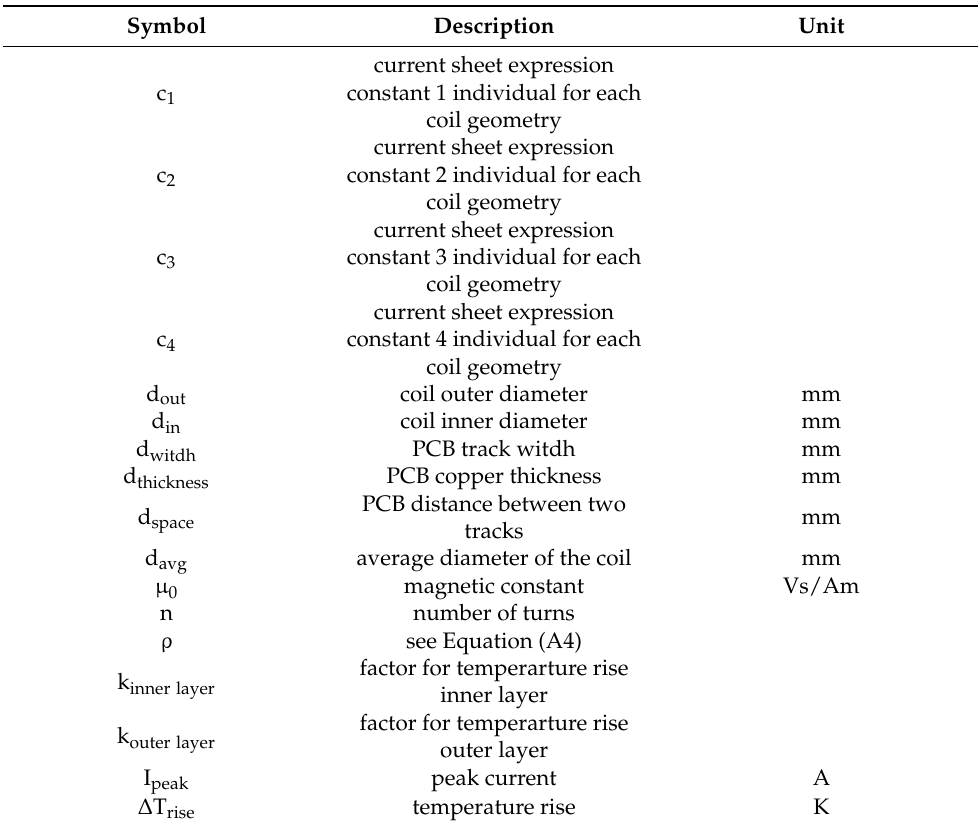
Table A3. Notation